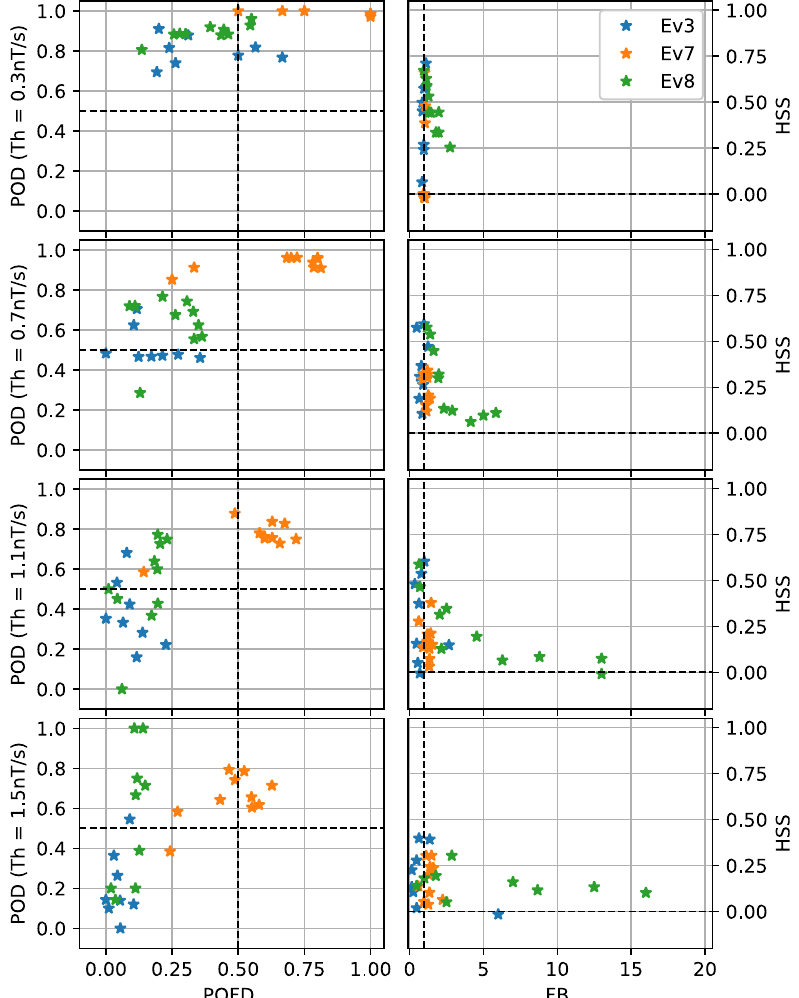
Fig. 9. d B /d t metrics results for thresholds 0.3, 0.7, 1.1, and 1.5 nT/s for the most intense storm events 3, 7, and 8. Probability of detection (POD) versus probability of false detection (POFD) in the left side panels, where dashed lines mark probability 0.5. An ideal panel would have all the points in the left top box in each panel. The panels on the right hand side show Heidke skill score (HSS) versus frequency bias (FB) where the horizontal dashed line marks the no skill score (HSS = 0) and the vertical dashed line marks the perfect FB score (FB = 1). An ideal model would have all the points above the horizontal line and along the vertical